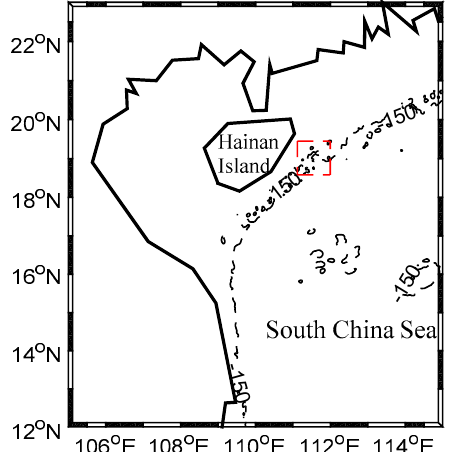
Figure 7. A presumed offshore area in South China Sea for FOWT-SFFC.